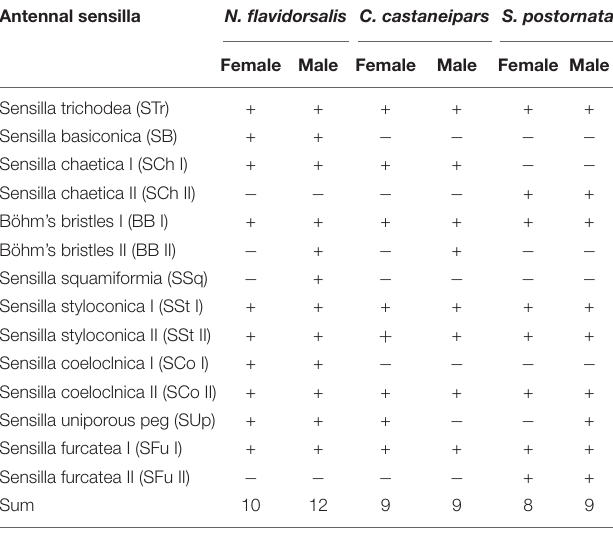
TABLE 3 | The distribution of nine types of antennal sensilla among three Limacodidae species. Antennal